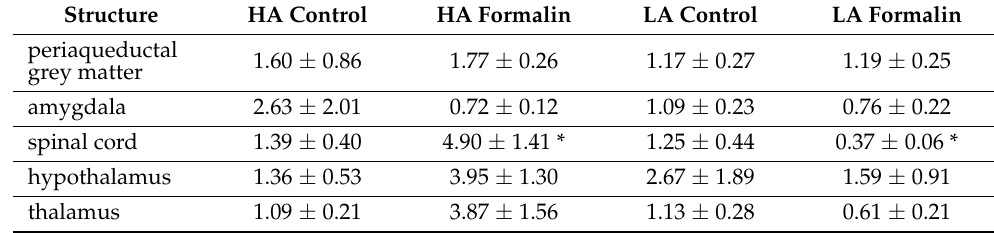
Table 7. Interleukin 1 β (Il-1 β ) mRNA levels in HA and LA mice in the interphase of the formalin test. Mice were injected with 5% formalin (in PBS) into the dorsal aspect of the hind paw ( n = 4–6). Samples were harvested 15 min post-formalin. Results were analysed within each line with two-way ANOVA followed by Bonferroni’s post-hoc test. Statistical significance was depicted as follows: * p ≤ 0.05 (vs.